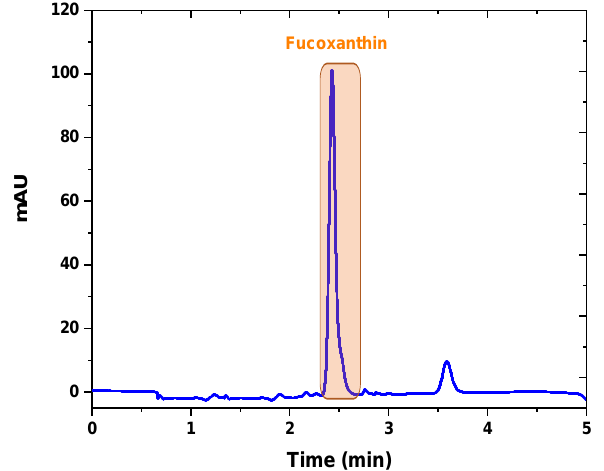
Figure 7. Prep-HPLC chromatogram for N. shiloi extract obtained at 450 nm. Figure 7. prep-HPLC chromatogram for N. shiloi extract obtained at 450 nm. 2.4. Confirmation of Purified Fucoxanthin with UV-vis Spectroscopy and Mass Spectrometry